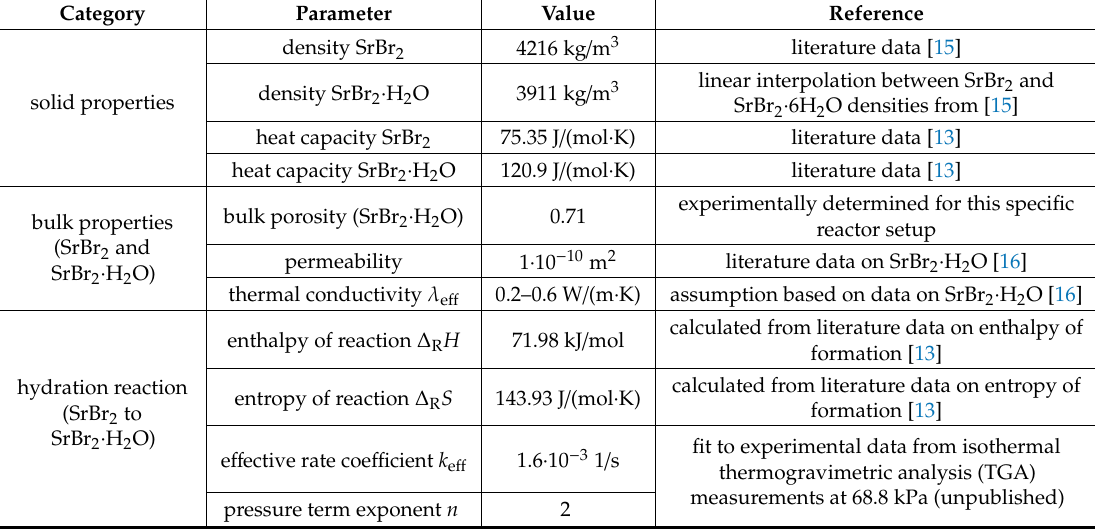
Table 1. Chemical and physical properties of the SrBr 2 /H 2 O reaction system.